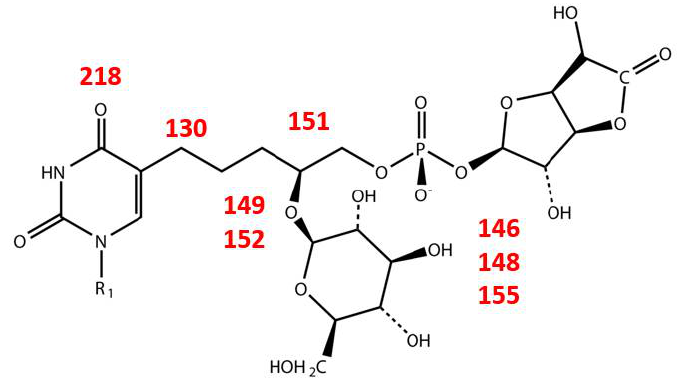
Figure 6. Detailed structure of the hypermodified base in SP-15 DNA with potential phage proteins indicated in red.